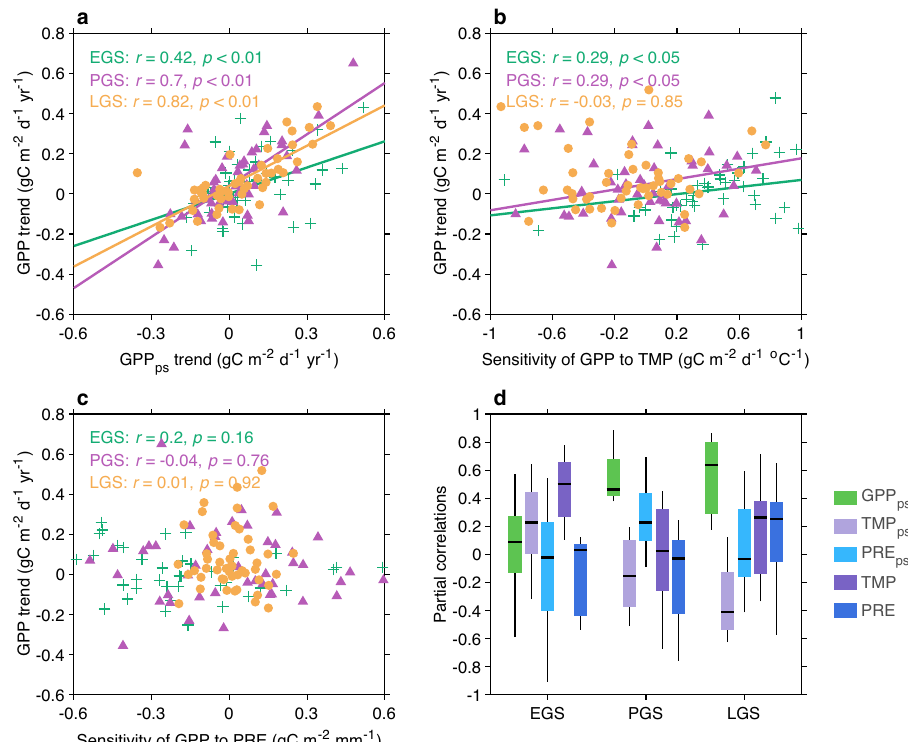
Fig. 2 Site-based vegetation growth carryover versus climatic effects. a Scatterplot of the gross primary productivity (GPP) trend for each season against that of the preceding season across 50 FLUXNET sites. b Scatterplot of the GPP trend for each season against the GPP sensitivity to concurrent temperature across 50 FLUXNET sites. c Scatterplot of the GPP trend for each season against the GPP sensitivity to concurrent precipitation across 50 FLUXNET sites. In all panels, best- fi tting straight lines are shown for signi fi cant relationships, along with related statistics as annotated. d Partial correlation coef fi cients between anomalies of seasonal GPP changes and that of each driving factor, based on measurements from 11 Ameri fl ux sites. Boxplots show the maximum, upper-quartile, median, lower-quartile, and minimum of the distribution across sites. EGS, PGS, and LGS represent early, peak, and late growing season,